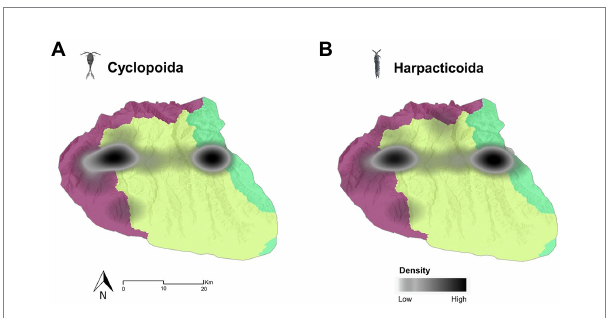
FIGURE 6 Kernel density estimation maps of the non-stygobitic cyclopoid (A) and harpacticoid (B) copepods species richness across the Lessinian Massif. The different colours of the base map layer represent the three distinct drainage basins (Western Lessini in purple, Lessinian Core in light green, and Eastern Lessini in bright green).